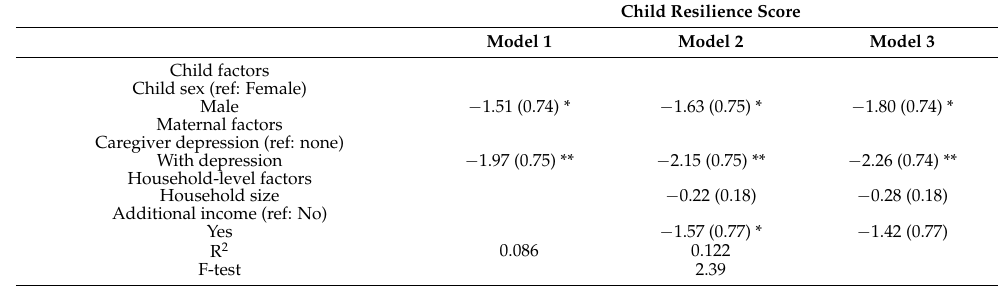
Table 6. Individual- and household-level factors that are associated with child resilience with adjustment for community level factors using school classification (fee-paying or